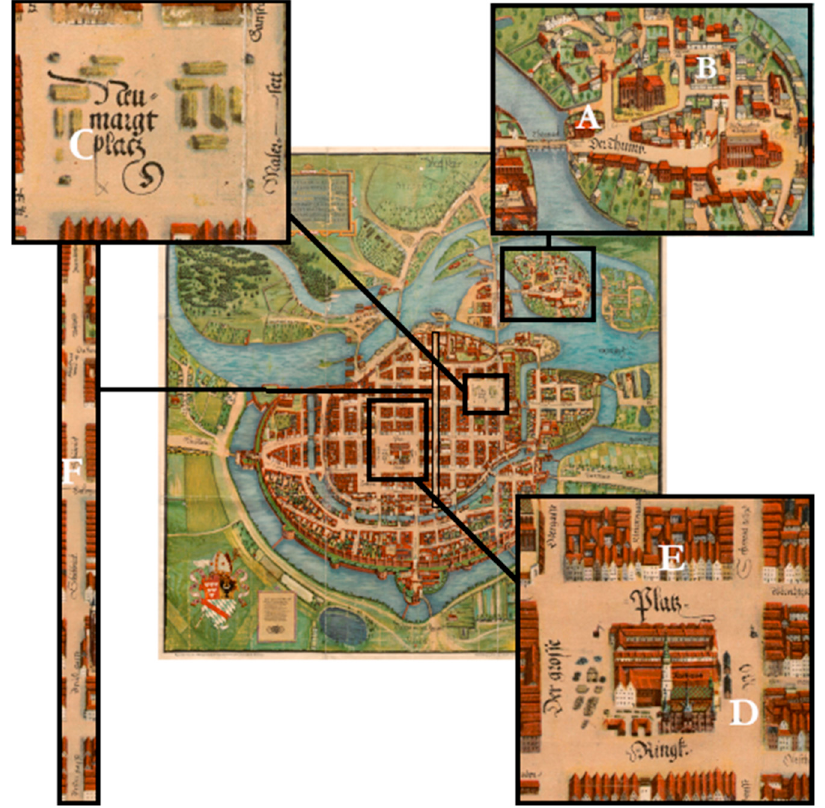
Figure 1. Plan of the late medieval Wrocław and location of the discussed sites (Contrafactur der Stadt Breslau 1562, Barthel Weiner) oai:www.bibliotekacyfrowa.pl:39530 (accessed on 5 August 2021). Description: M. Pietruszka. A: Katedralna St., Ostrów Tumski (Cathedral Island); B: ś w. Idziego St., Ostrów Tumski (Cathedral Island); C: Nowy Targ Square; D: Market Square; E: Market Square 50-Igielna St. 18; F: Szewska St.